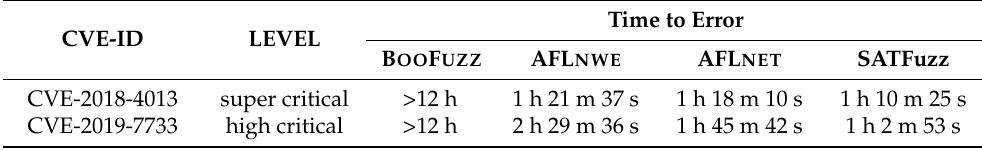
Table 6. The vulnerabilities found and average time to error